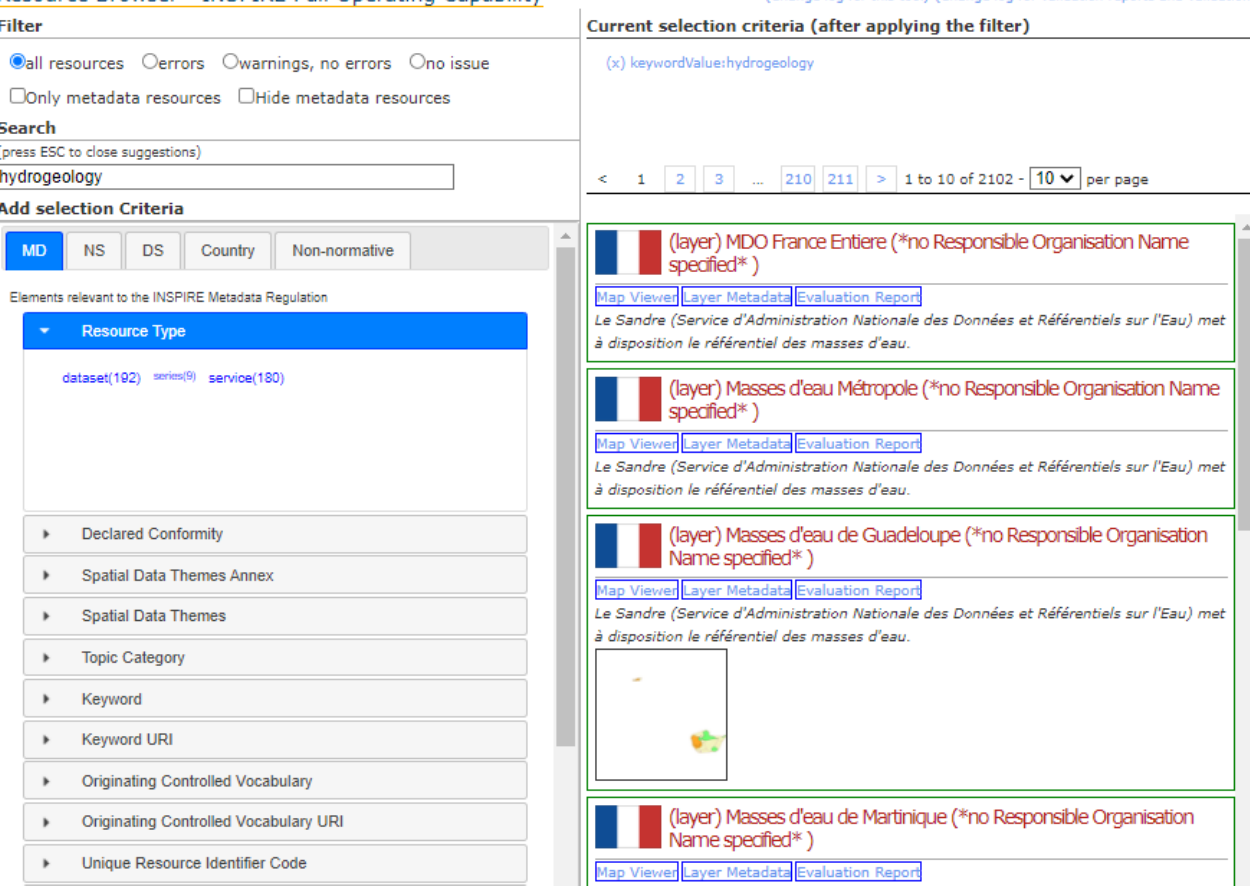
Figure 8. INSPIRE Metadata Browser, Source: European Commission, Joint Research